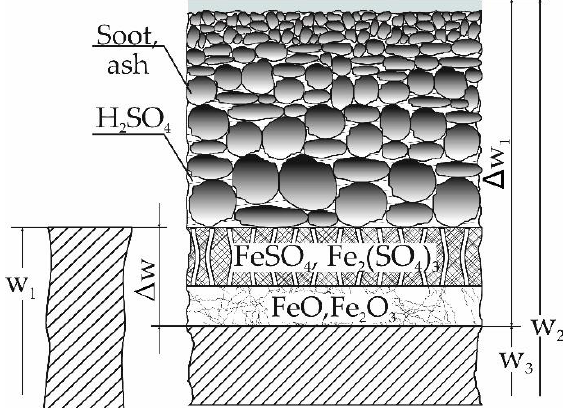
Figure 3. Drawing of corrosion processes investigated.